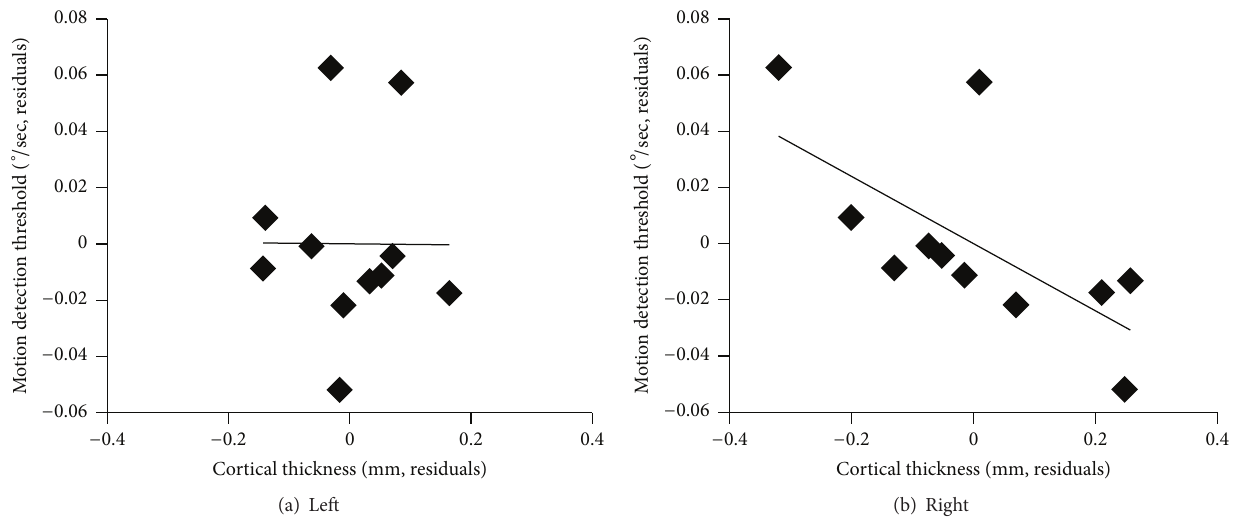
Figure 1: Partial correlation between mean cortical thickness in the left (a) and right (b) PTR and visual motion detection thresholds in deaf people after controlling for age. In the right PTR but not in the left, cortical thickness correlated with visual motion detection